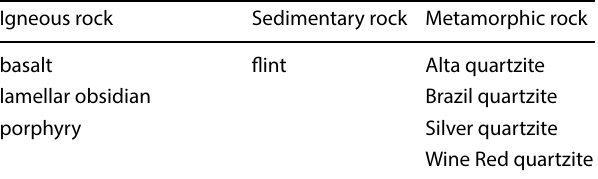
Table 1 Rocks used in the investigations Igneous rock